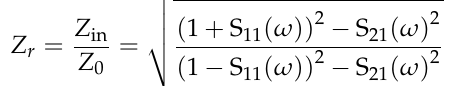
Figure 3. ( a ) Simulated absorption curves of proposed patterned graphene metamaterials absorbers. ( b ) Top view of disk-patterned graphene unit cell. ( c ) Top view of ring-patterned graphene unit cell. ( d ) Top view of circled minus-patterned graphene unit cell.